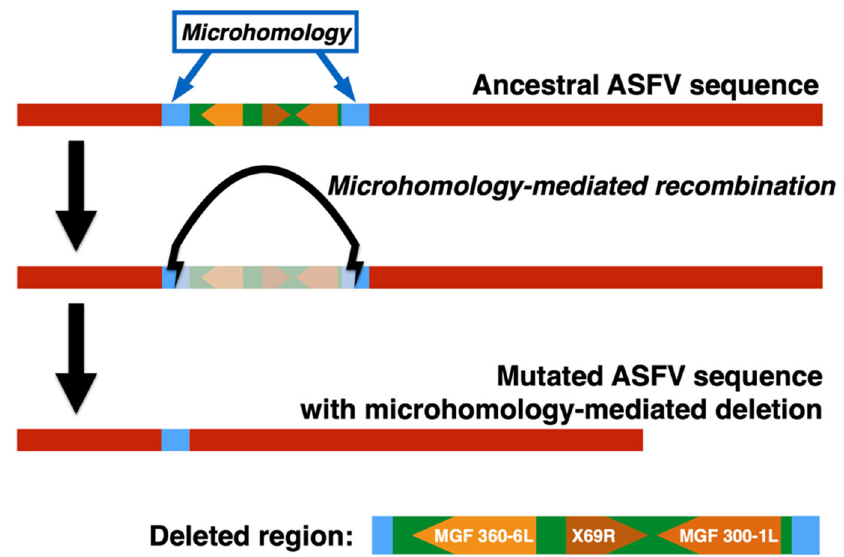
Figure 3. Scheme of the process of microhomology-mediated deletion and the structures of the ancestral and mutated sequences.